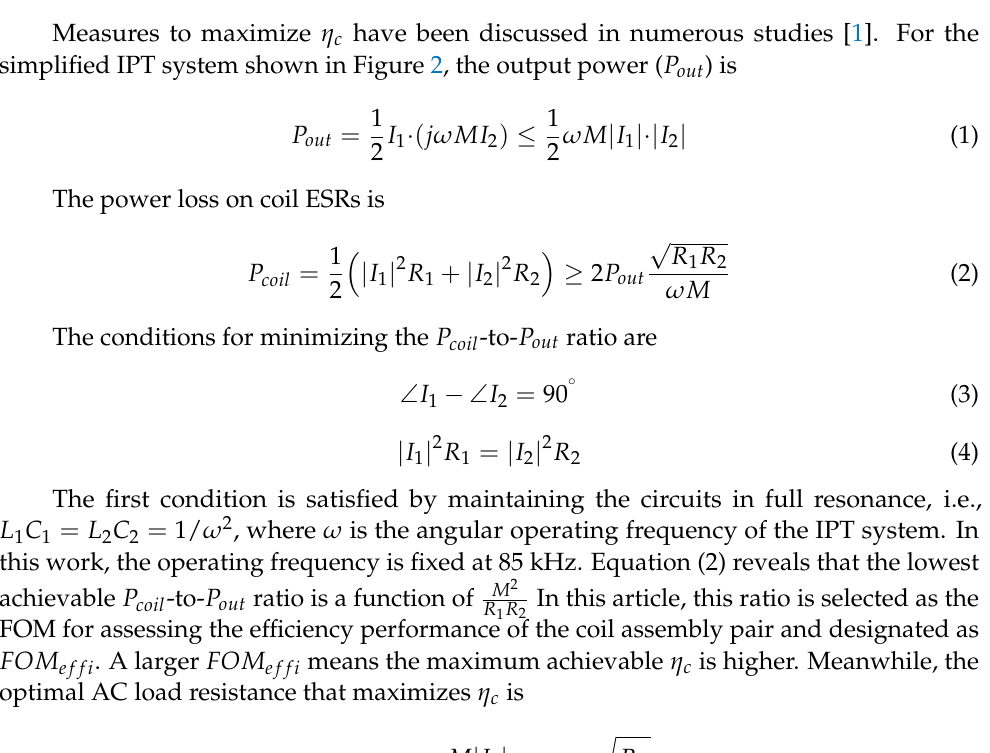
Figure 2. Simplified schematic of series-series-compensated IPT system.